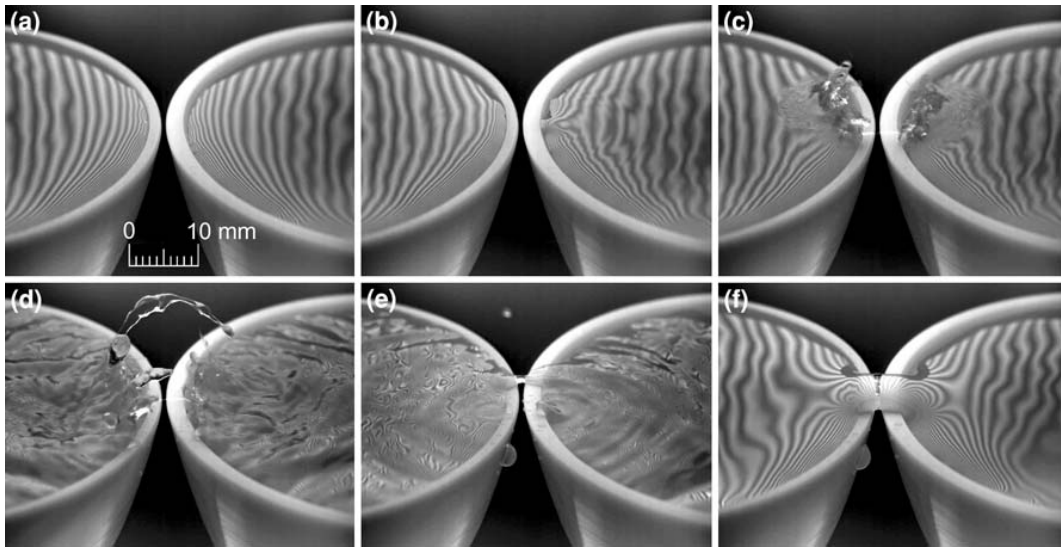
Figure 7. Bridge formation between two Teflon beakers using fringe projection. The shape of the water surface is contoured by the distortions of the otherwise parallel line reflections of an illuminated grid reflected by the surface (for a detailed description of this technique, see e.g., [159].) In (b) the high voltage was applied to the electrodes, in (e) a watery connection formed, in (f) the bridge was stabilized (from